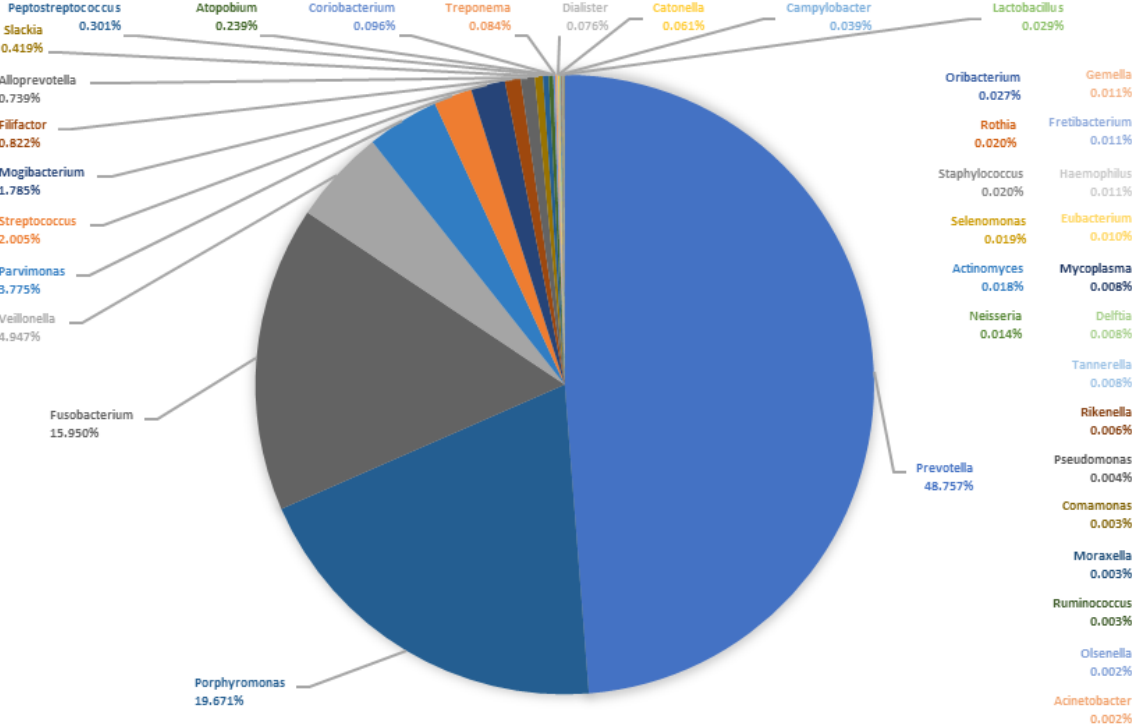
Figure 6. Median microbiome of all pus samples ( n = 50). The pie chart shows the proportion of the bacterial genera of the sum of all medians of the relative abundances.